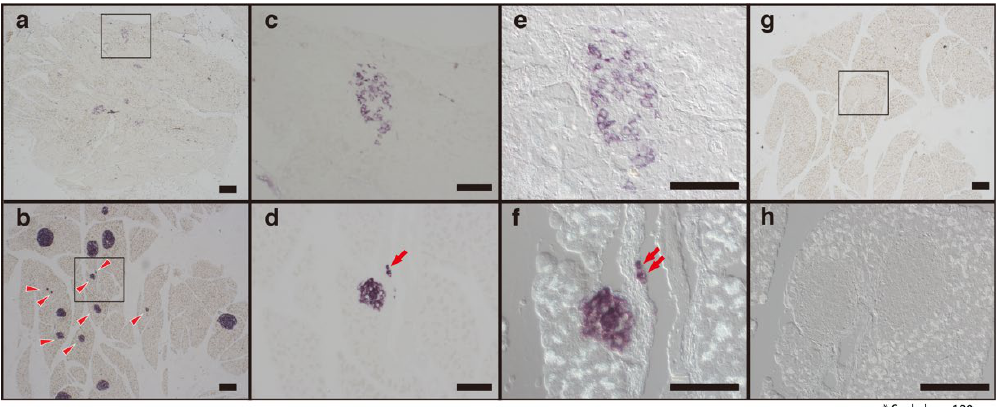
Figure 5. Treatment of hydrolyzed SF leads to the regeneration of pancreatic β -cells. DB-NT ( a , c , e ) and DB-T ( b , d , f – h ) pancreatic tissues were harvested and paraffin-embedded for RNA in situ analysis with antisense mouse insulin probe ( a – f ) or not ( g and h , negative control). Panels ( c ) and ( d ) show higher magnification images of the boxed areas ( a , b ). Differential interference contrast (DIC) microscopy images of pancreatic islets from the DB-NT ( e ) and DB-T ( f , h ) groups. Red arrowheads point to the pancreatic islets that have a small size ( b ) and arrows indicate the neogenesis of the pancreatic β -cell ( d , f ). Scale bars are indicated.